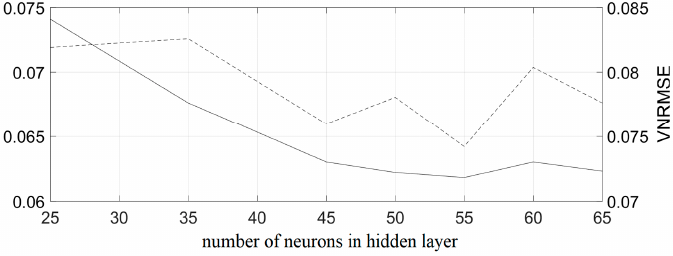
Figure 4. The error for different values of learning rate for training ( upper ) and validation ( lower ) data.